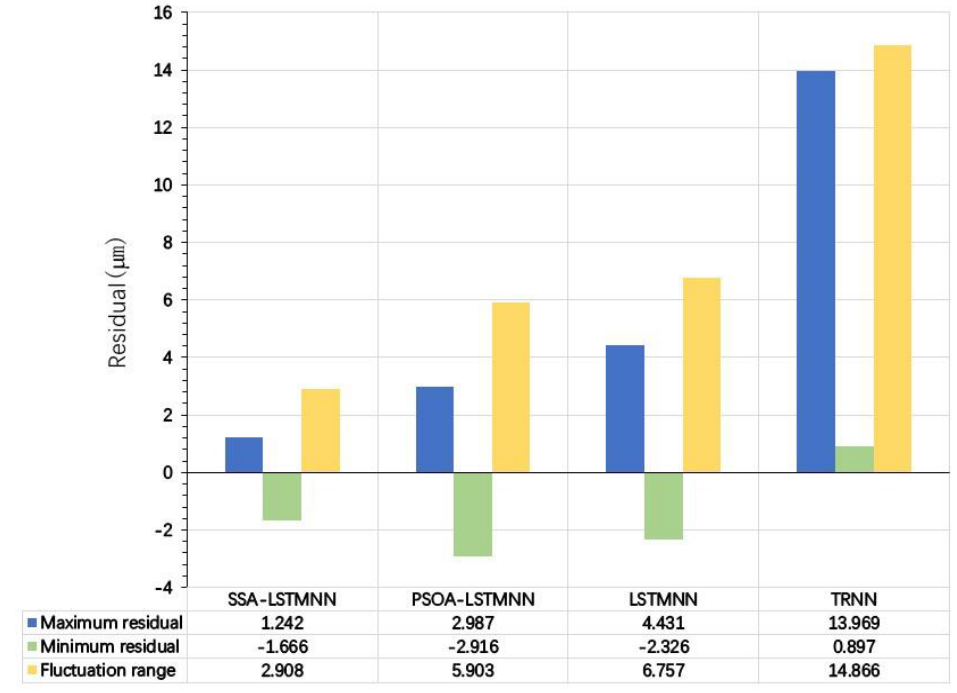
Figure 21. Residual curves for each model at velocity V 3 = 8000 mm/min.